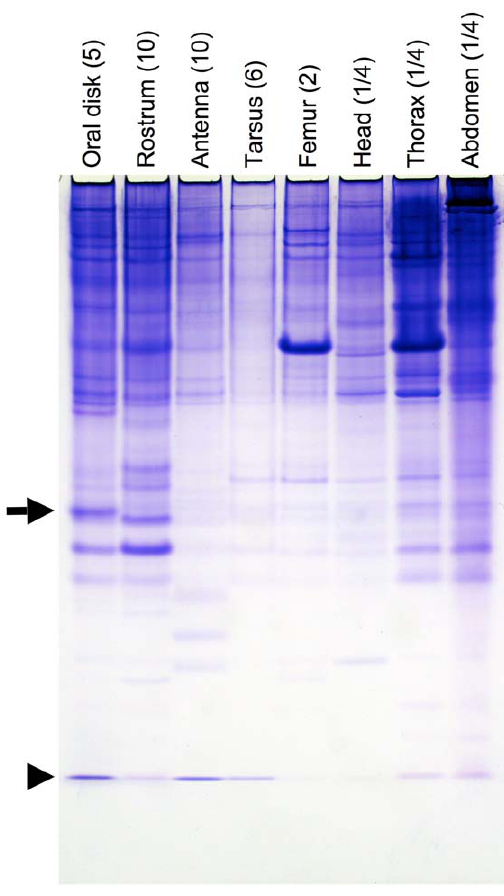
Figure 1. Identification of an oral disk-specific protein by native PAGE analysis. Protein was extracted from each experimental tissue of females at day 3 adult stage, separated by 15% native PAGE, and visualized with Coomassie Brilliant Blue-R250 staining. The source of the protein is shown at top of the gel profile. The number of individuals from which the tissues were collected is indicated in parenthesis. The arrow and arrowhead indicate the migration of an oral disk-specific protein and a chemical sense-related lipophilic ligand- binding protein (CRLBP), respectively.